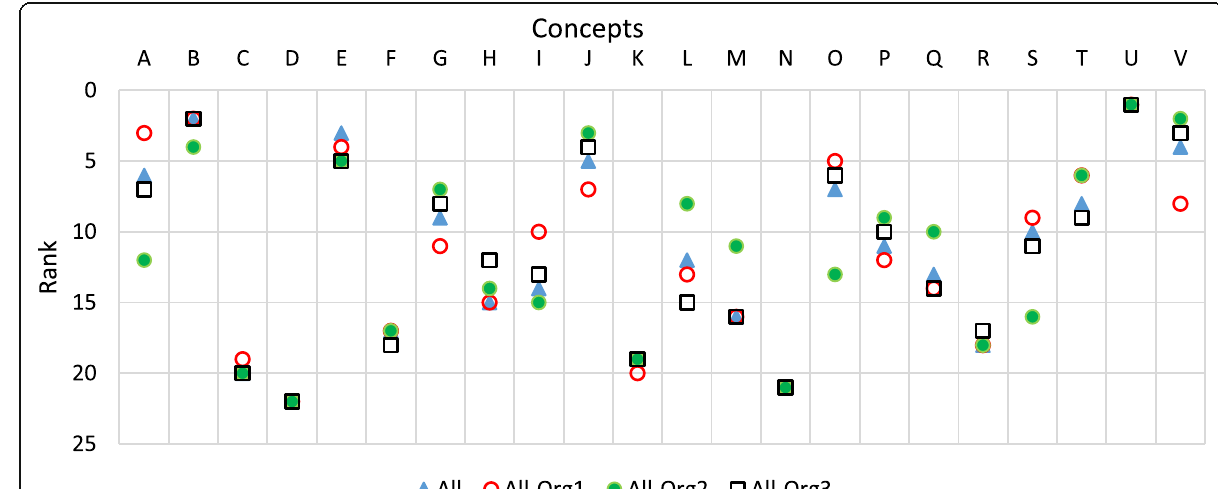
Fig. 5 Changes in rankings with evaluations of each